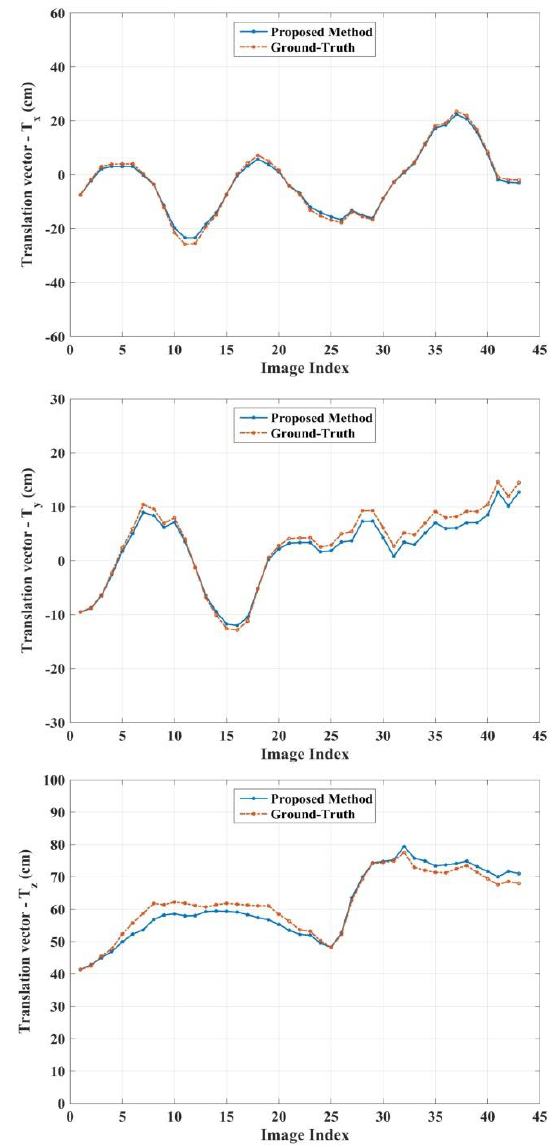
Figure 10. Estimated camera translation vector against Ground-Truth